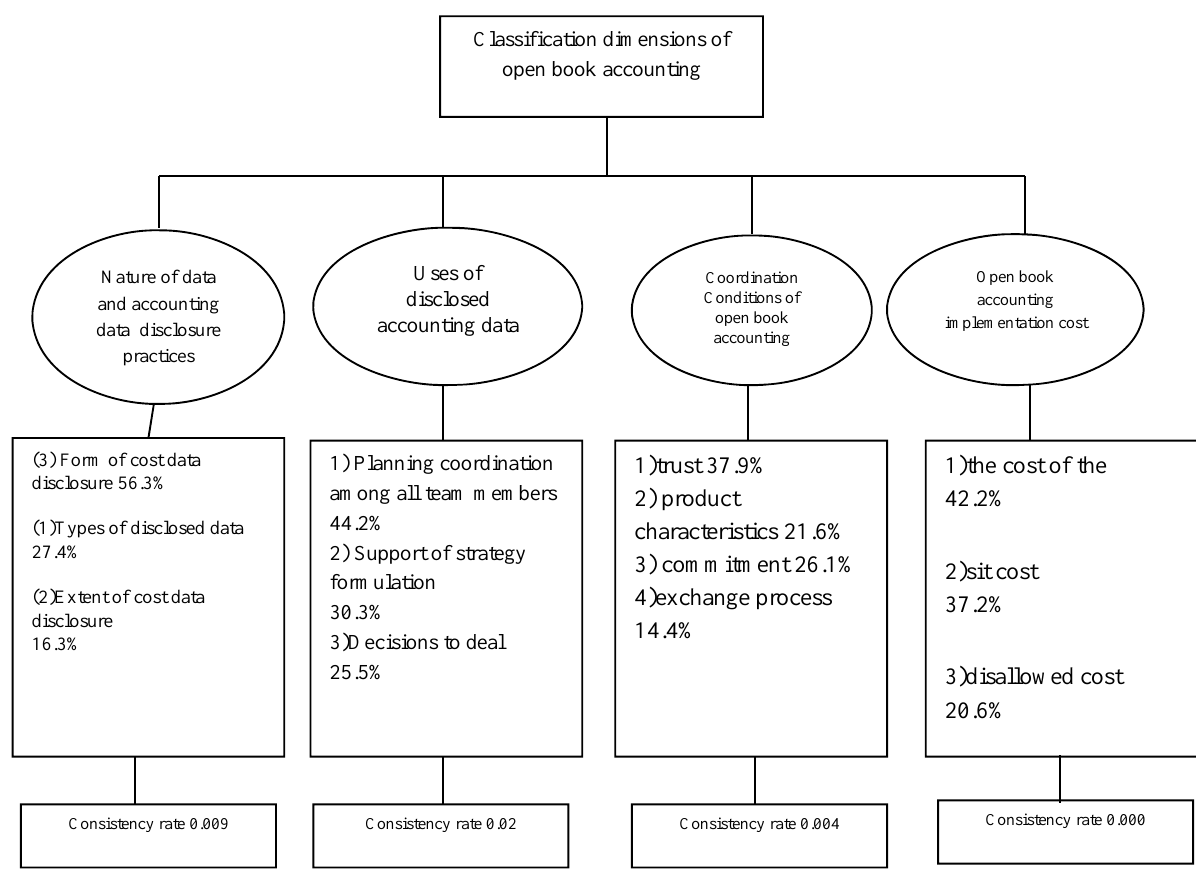
Fig. 3. Data analysis and